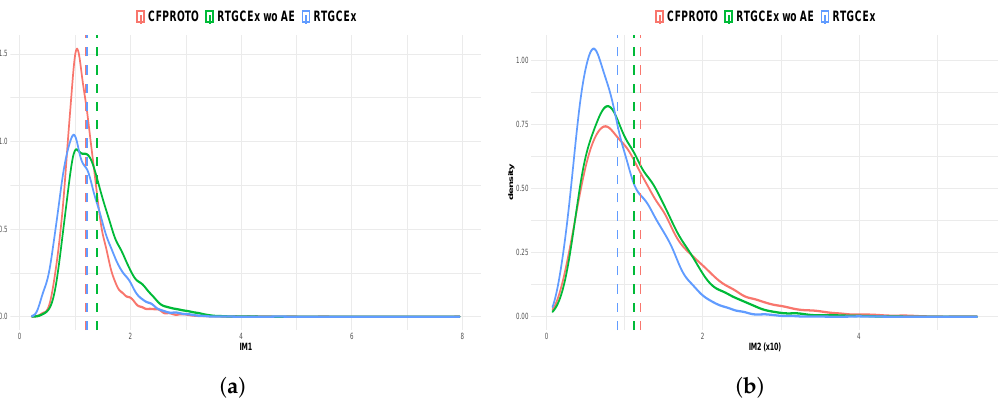
Figure 10. Distribution plots for each method in terms of IM1 and IM2 ( × 10) metrics. The dashed lines represent the mean. ( a ) IM1 distribution plots. ( b ) IM2 ( × 10) distribution plots. Table 3. This table represents the probabilities that a counterfactual instance has a lower IM1 or IM2 depending on the method used.